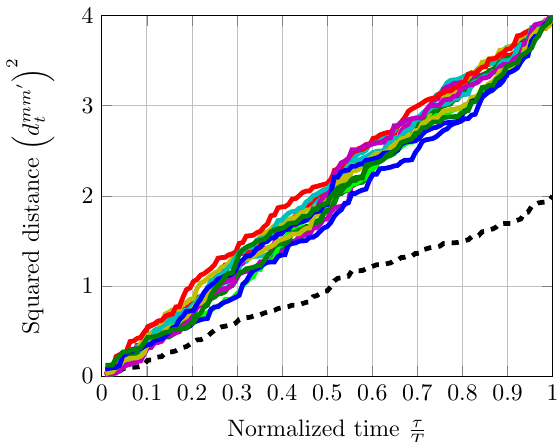
Fig. 9 Distances over time between OFDM signals where codewords have been pre‑coded by a Hadamard orthogonal matrix. Number of different symbols in codewords # K = 1 represented by the black dashed curve; number of different symbols in codewords # K = 2 represented by colored curves